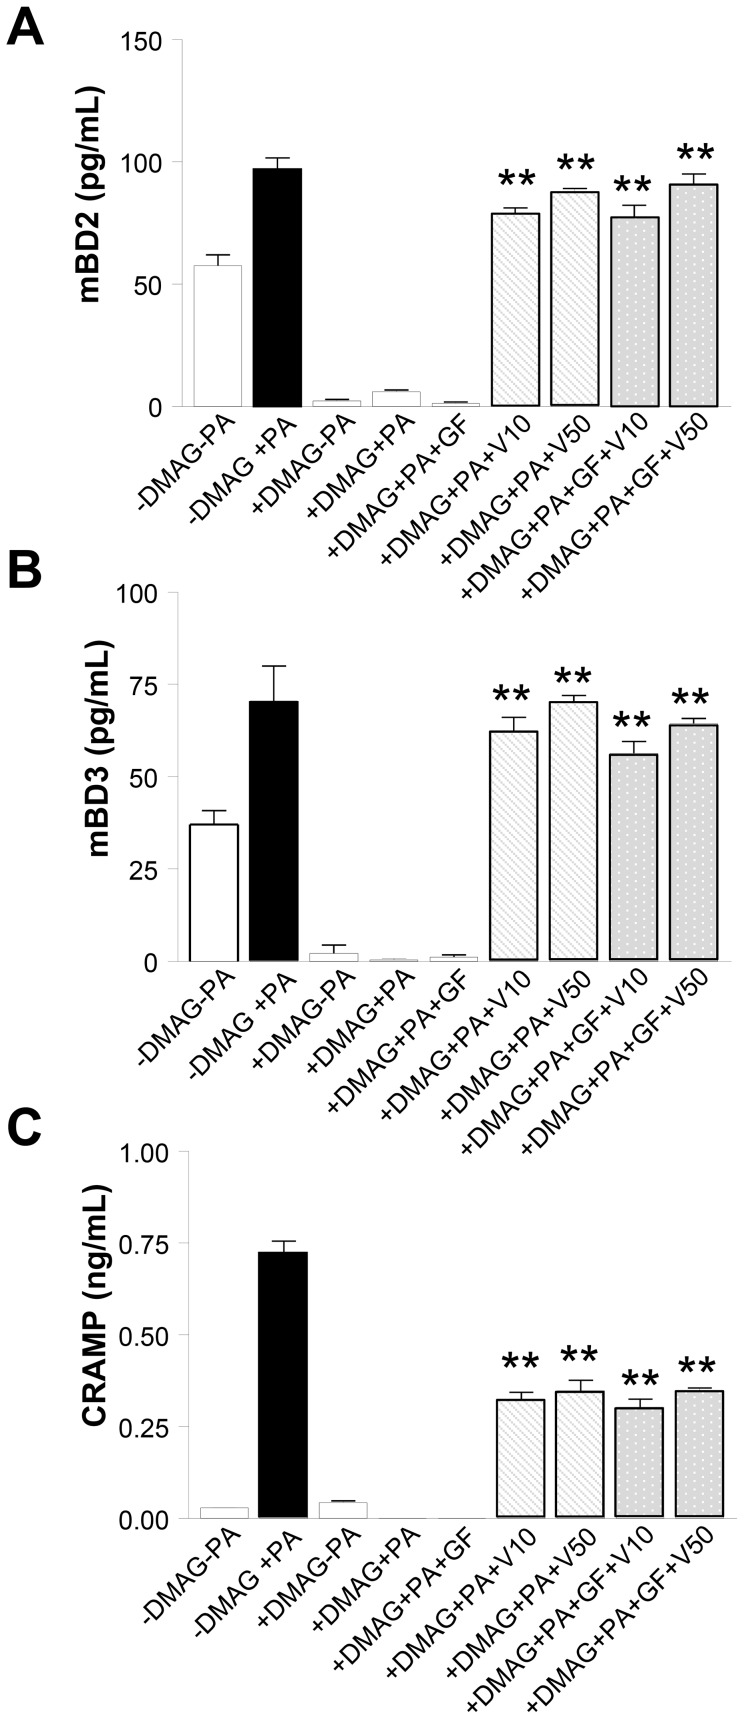
In vitro expression of antimicrobial peptides after HIF-1α inhibition and growth factor treatment.PMN were incubated +/− DMAG treatment (10 µM) for 18 hours, then treated (4 hours) with either VEGF alone (10 and 50 µg/mL), a growth factor (GF) cocktail (HGF, FGF and EGF) or a combination of VEGF+GF cocktail. After challenge with P. aeruginosa (2.5∶1 ratio of bacteria∶cells), antimicrobial protein levels from supernatants were determined by ELISA. mBD2 (A), mBD3 (B) and CRAMP (C) were significantly up-regulated after VEGF treatment alone and following GF cocktail+VEGF treatment. ** P<0.01.